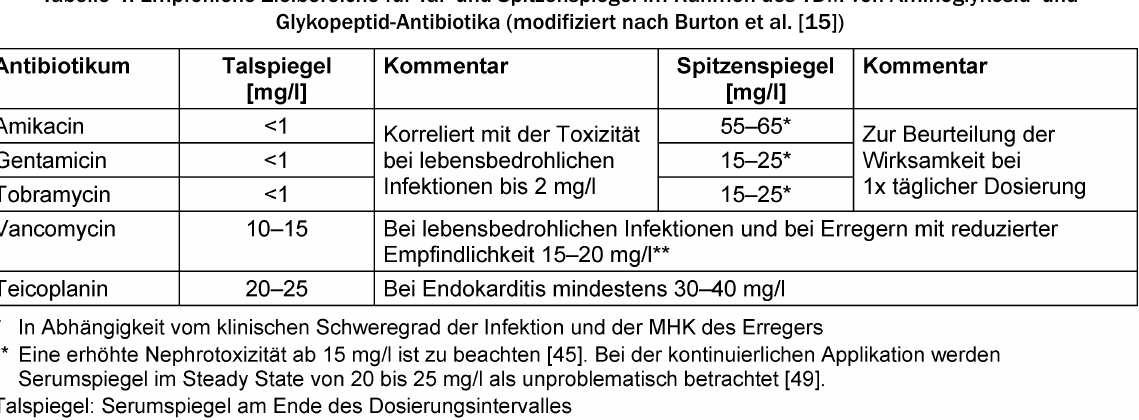
Tabelle 4: Empfohlene Zielbereiche für Tal- und Spitzenspiegel im Rahmen des TDM von Aminoglykosid-